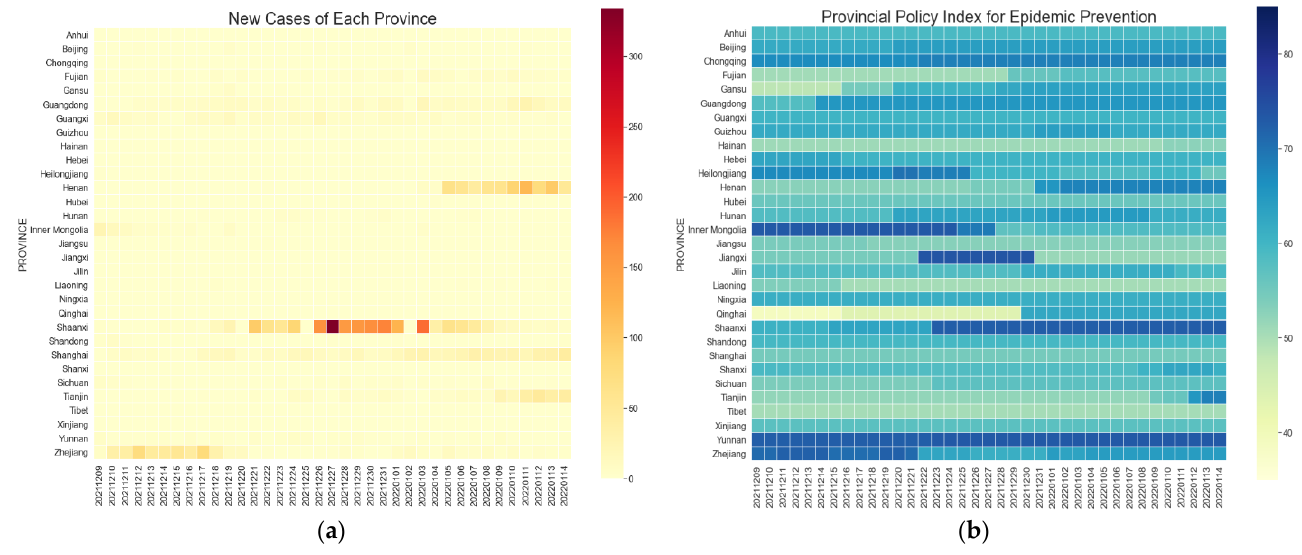
Figure 2. ( a ) Temporal variations of new cases by province; ( b ) temporal variations of policy index by province.